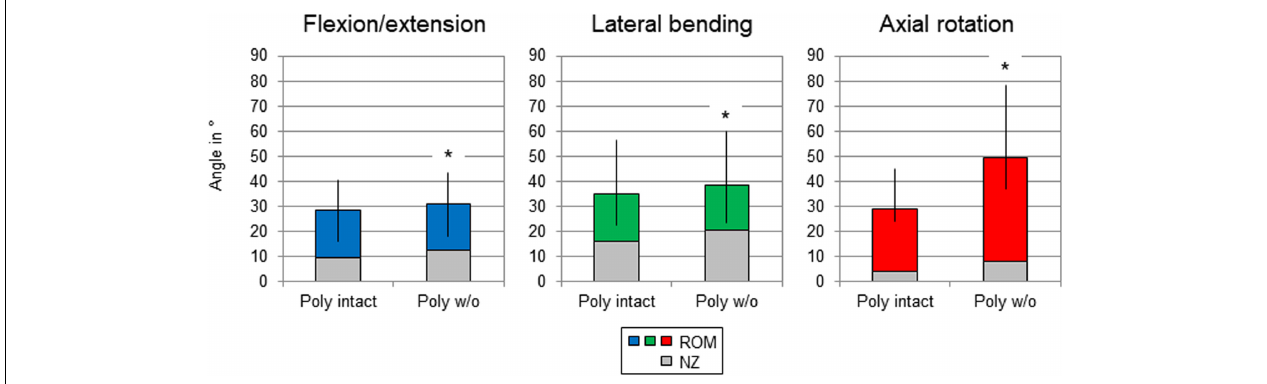
FIGURE 3 | Graphical illustration of the results for total T1-T12 range of motion (ROM) and neutral zone (NZ) at pure moments of ± 5 Nm ( n = 8) depending on primary motion plane and testing step. Significant differences compared to the previous condition ( p < 0.05) are marked with an asterisk. TABLE 2 | Results for total T1-T12 range of motion at pure moments of ± 5 Nm ( n = 8) depending on primary motion plane and testing step. Motion plane